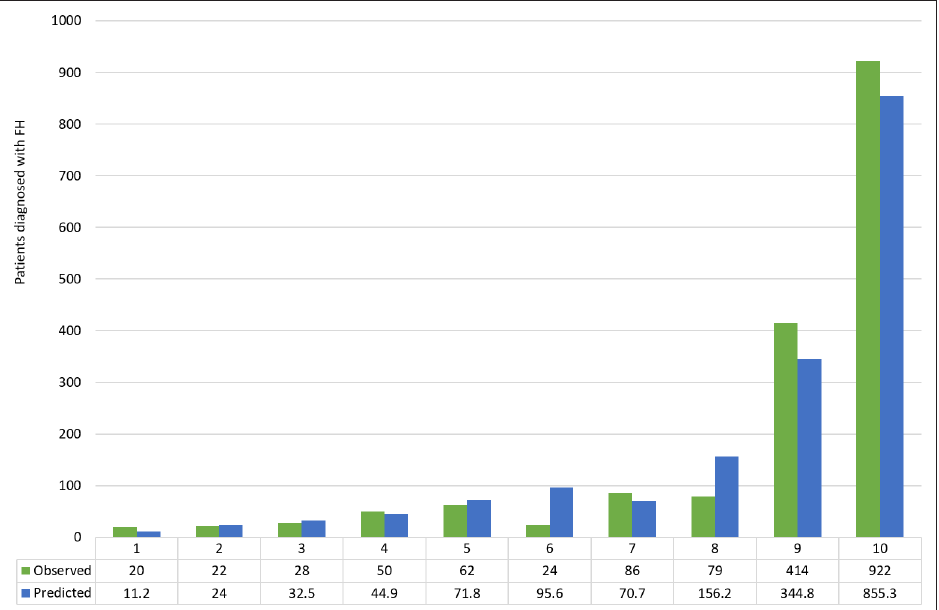
Figure 2 FAMCAT model calibration of observed versus predicted cases of familial hypercholesterolaemia in the external validation cohort by deciles of predicted probability